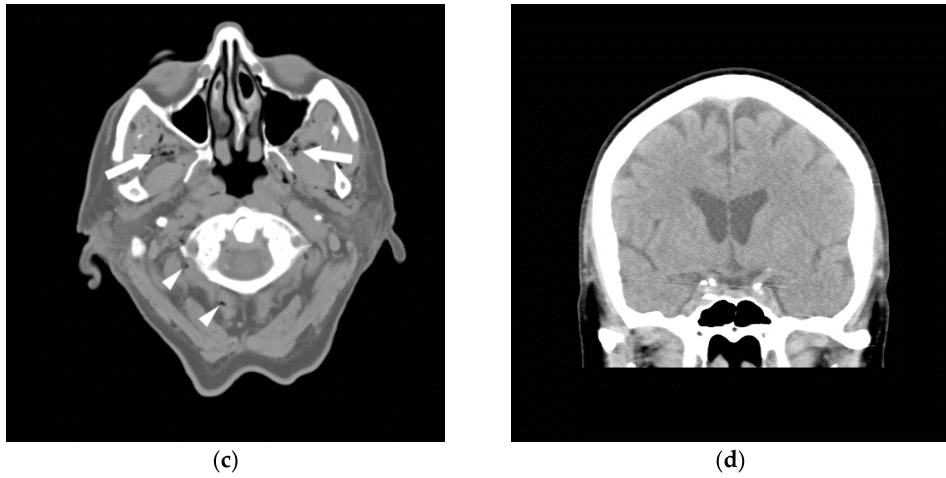
Figure 1. A 35 ‐ year ‐ old man was transferred from an outside hospital with altered mental status following the placement of a peripheral intravenous line. A CT of the brain was performed in the emergency room. Axial ( a ) and coronal ( b ) CT revealed a moderate amount of air in the cavernous sinuses bilaterally (arrows) as well as multiple small foci of air in the region of the pterygoid venous plexuses ( c ), scattered in the soft tissues and in the extradural space at the level of the upper cervical spine (arrowheads). A follow ‐ up CT ( d ) was performed the next day, which revealed resolution of the previously seen air. In this case, the patient made a full recovery.